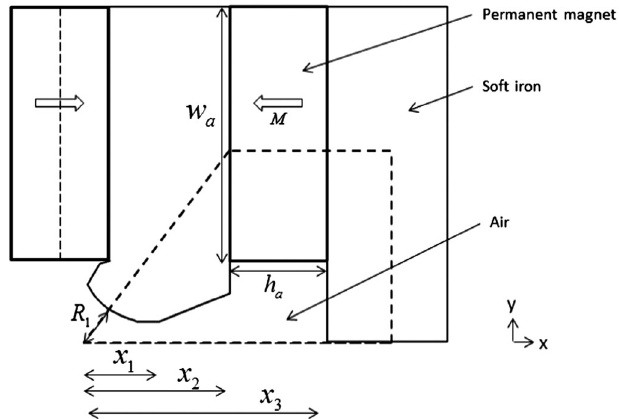
FIG. 2. Hybrid quadrupole geometrical dimensions. The con- tour integral for Ampere ’ s theorem computation is shown. All PM have the same dimension for simplicity. PM can be placed on poles top to increase the gradient.